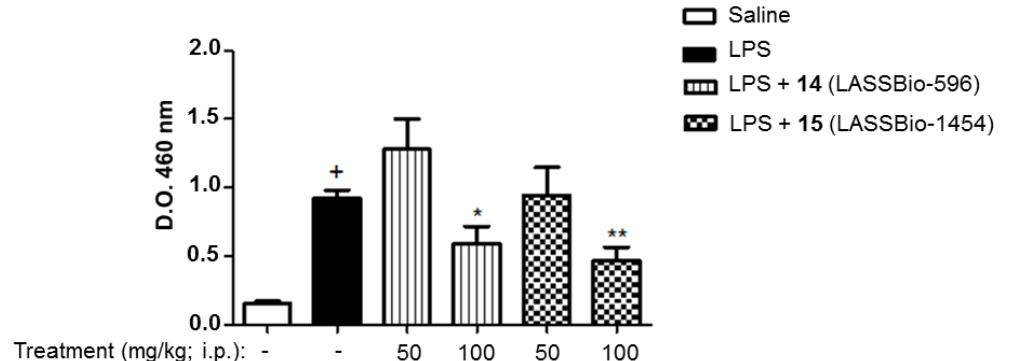
Figure 5. Effect of the carboxyamide derivatives 14 and 15 (50 and 100 mg/kg; i.p.) on tissue neutrophil infiltration in a murine model of acute lung inflammation induced by LPS (25 μ g/animal, i.n.). Values are mean ± SEM from six animals. + p < 0.05 as compared with saline group; * p < 0.05 as compared with the group stimulated with LPS; ** p < 0.01 as compared with the group stimulated with LPS; ANOVA followed by Newman-Keuls Student